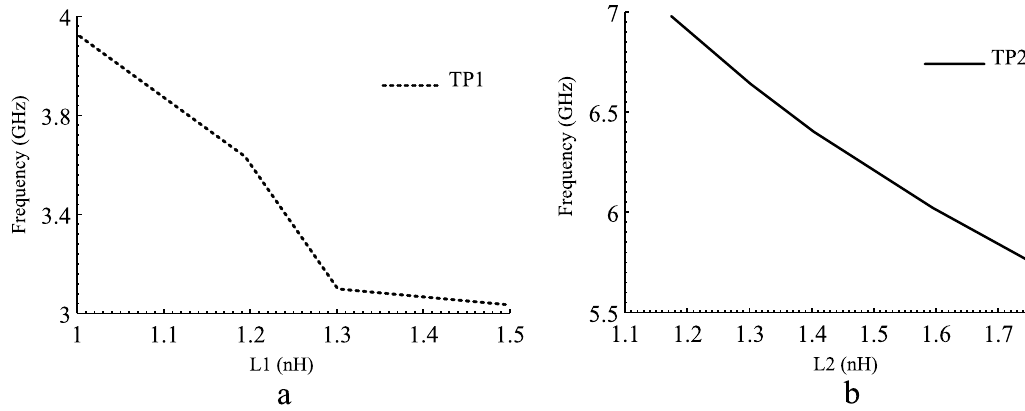
Figure 4. FR: ( a ) Variations of TP1 versus L1, ( b ) Variations of TP2 versus L2.